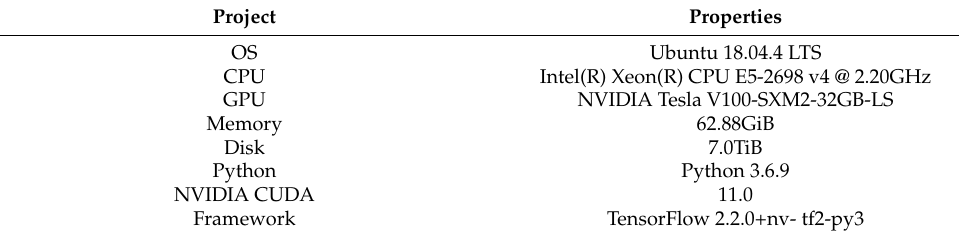
Table 19. Experimental